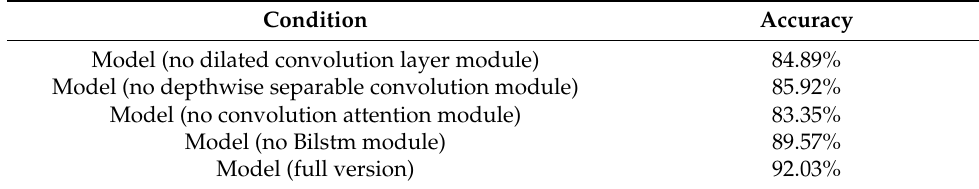
Table 2. Influence of different modules in the